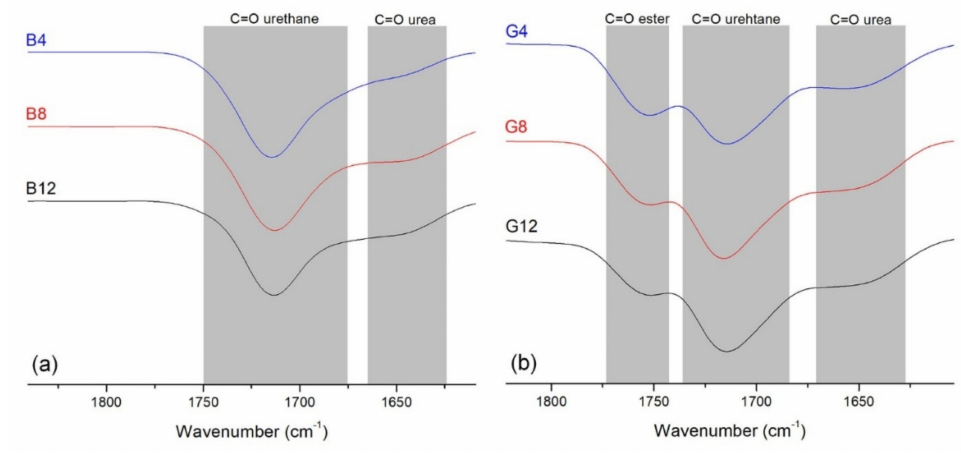
Figure 3. Highlights of FTIR spectra: ( a ) CD-PEG, and ( b )